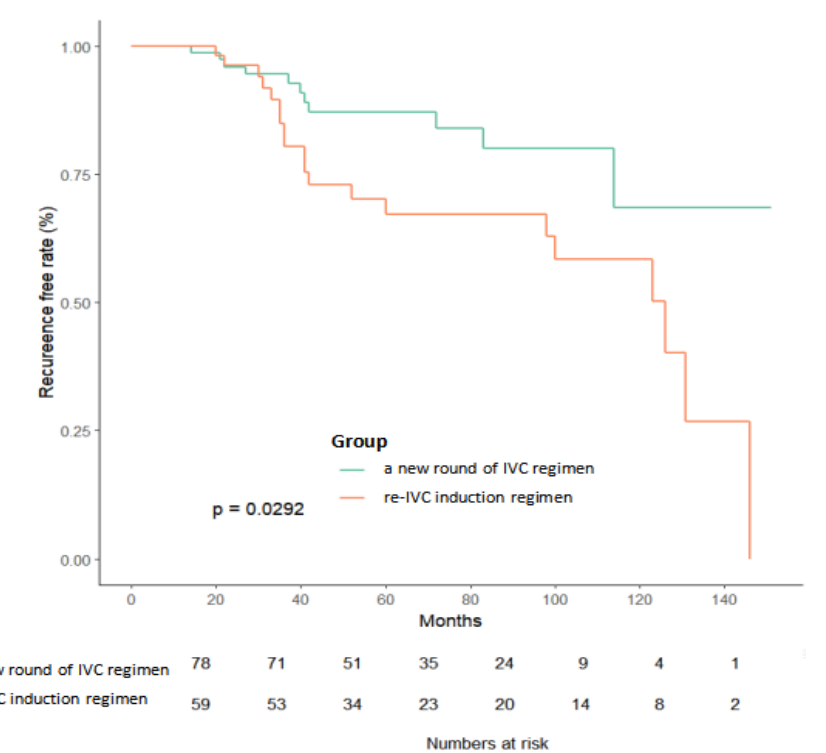
Figure 2. Non-recurrence curve after TURBT in two groups. Non-recurrence rate of the new round group was significantly higher than that of the original group ( p = 0.0292) in total study cohort.